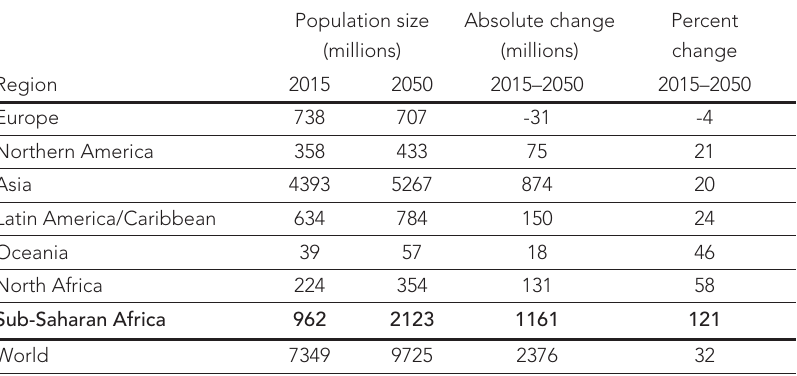
Table 1: Population Growth, 2015–2050, by region Population size Absolute change (millions)